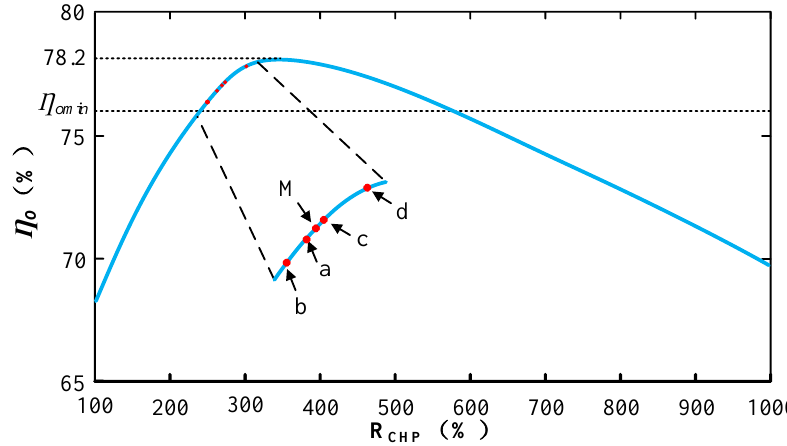
Figure 6. Simulation results of the relationship between CHP heat to power ratio and its overall